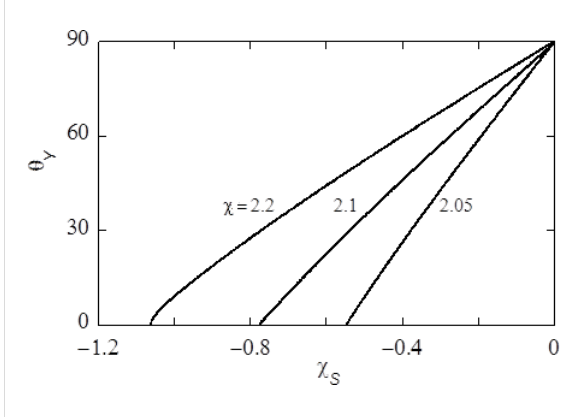
Figure 4: Contact angle of liquid on flat solid, θ Y as function of the interaction parameter of the liquid with the solid, γ S , for three different values of the interaction parameter of the liquid with the vapour, γ